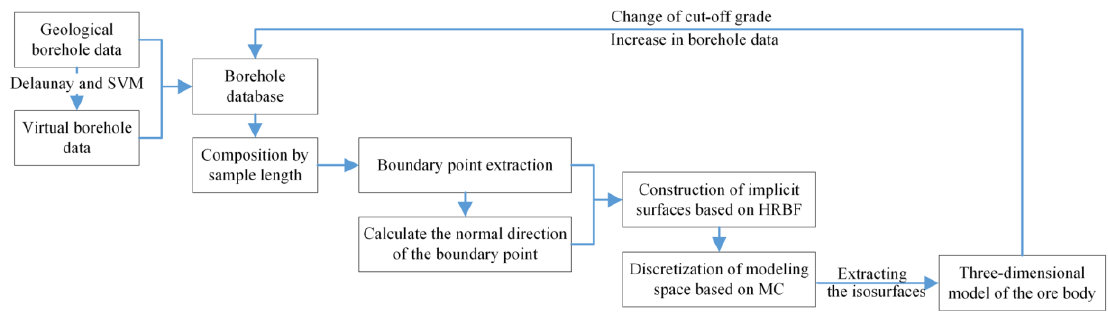
Figure 1. Three-dimensional Implicit Modeling Approach and Process for Ore Body.